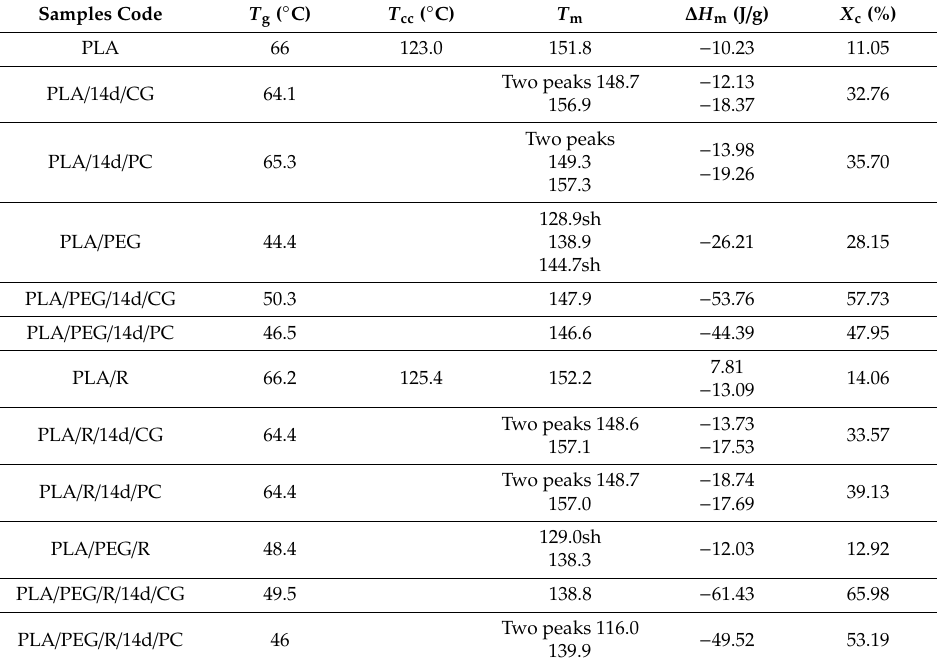
Figure 9. Differential scanning calorimetry (DSC) curves of undegraded and biodegraded PLA ( a ), PEG-plasticized PLA ( b ); PLA/R ( c ); PLA/PEG/R ( d ). Table 5. Thermal characteristics of the PLA based systems before and after fungal degradation determined by DSC.